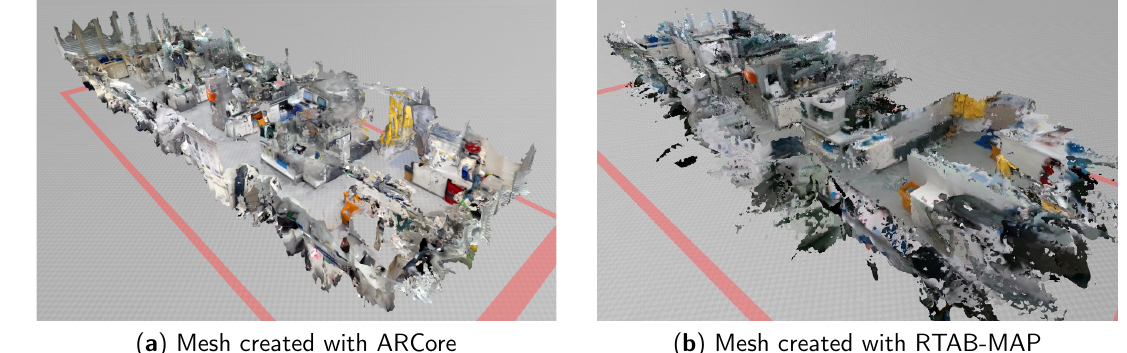
Figure 7. Mesh of the